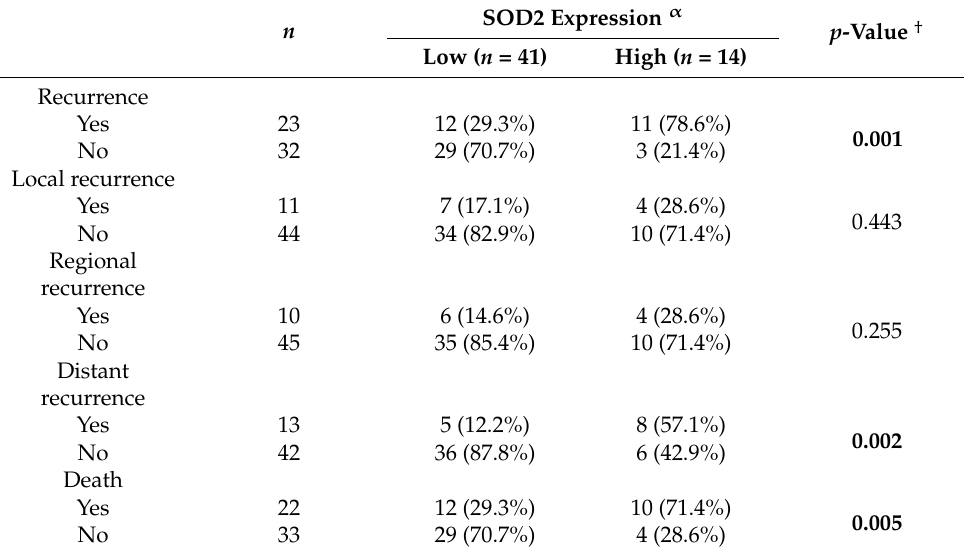
Table 2. Expression of SOD2 protein according to recurrence, local recurrence, regional recurrence, distant recurrence, and